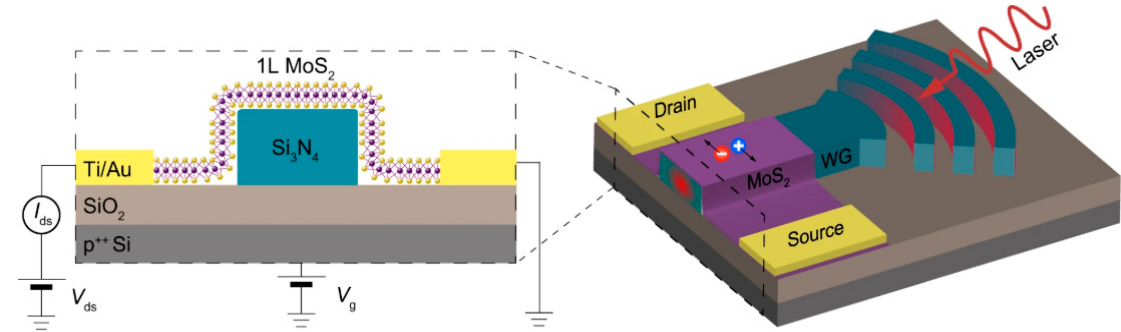
Figure 6. Scheme of a phototransistor and its implementation in a nanophotonic device. Reprinted with permission from ref. [27]. © 2019, Springer Nature.